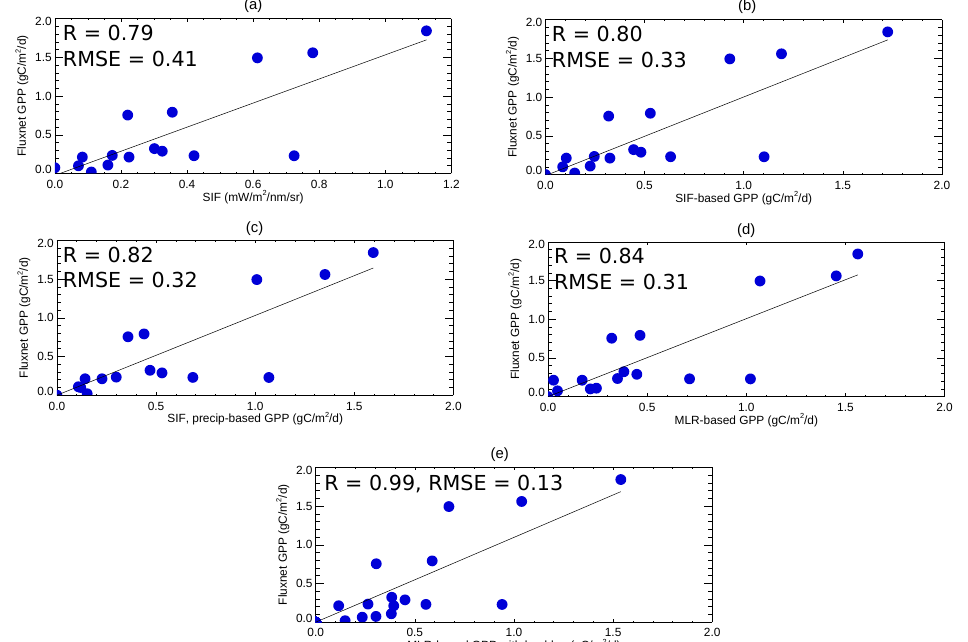
Figure 7. Relationship of mean monthly GPP (gC/m 2 /day) measured at FLUXNET stations with C4 grass vegetation (Table 1) used in this study and ( a ) GOME-2 SIF; ( b ) SIF-based GPP; ( c ) SIF- and precipitation-based GPP; ( d ) MLR-based GPP (SIF, precipitation, soil moisture as predictors); ( e ) MLR-based GPP with lead–lag. The Spearman’s correlation coefficient R and root-mean-square error RMSE (gC/m 2 /day) are